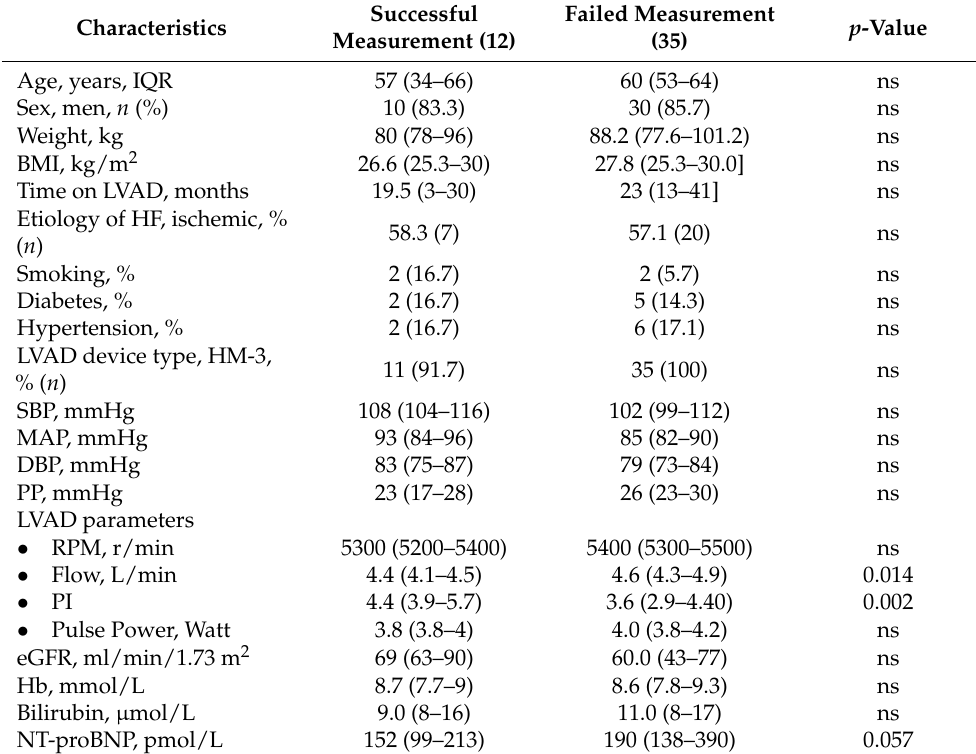
Table 1. Baseline characteristics of HF with an LVAD with successful or failed